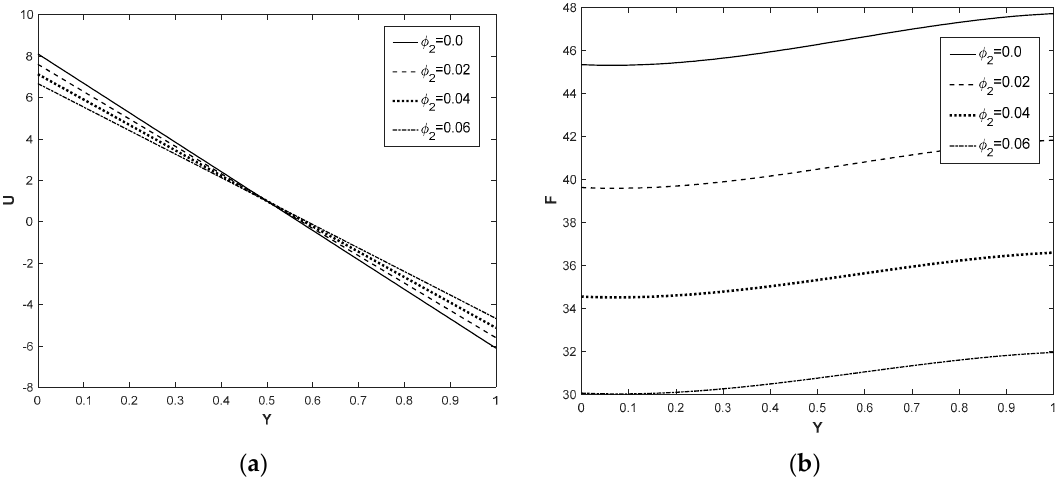
Figure 5. Velocity ( a ) and temperature ( b ) profiles for horizontal channel, for Pe = 1, λ = 50 and ϕ 1 = 0.1 and for different concentrations of Cu-nanoparticle volume fraction ϕ 2 .